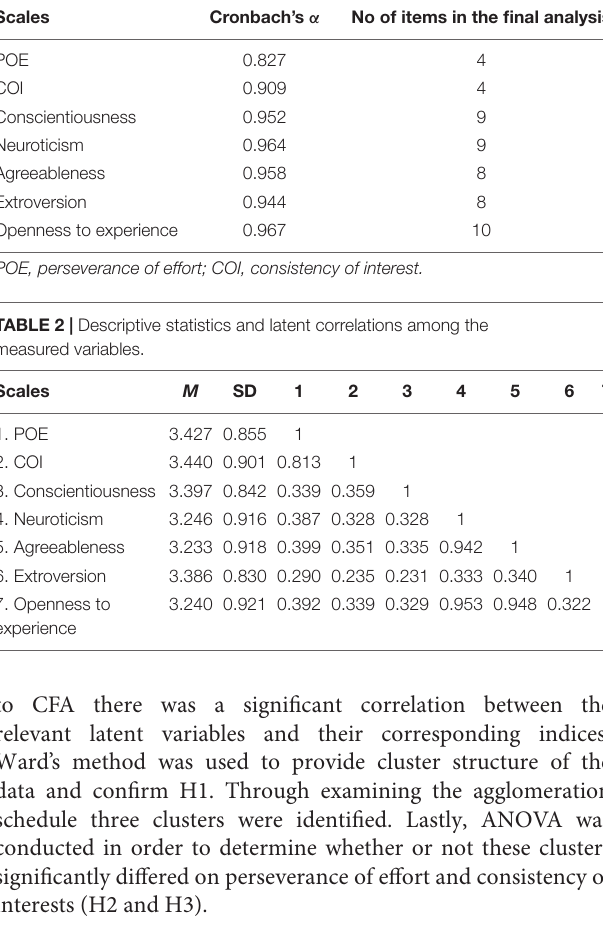
TABLE 1 | Reliability estimates of the variables.